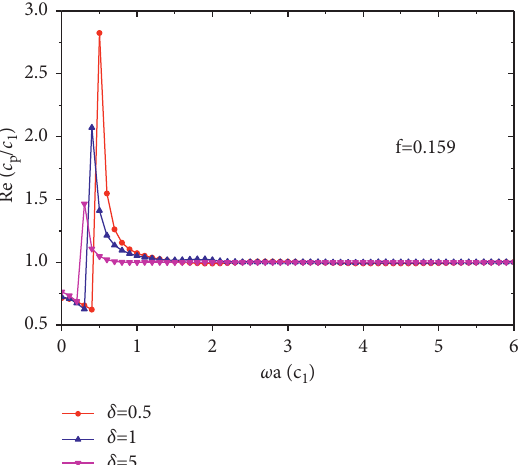
Figure 8: Comparison of ratios of the phase velocity in the composite material and matrix obtained by the differential method when quasi-P wave propagates in the composite material for inclusion volume fraction of 15.9% and δ � 0 . 5, 1, and 5,